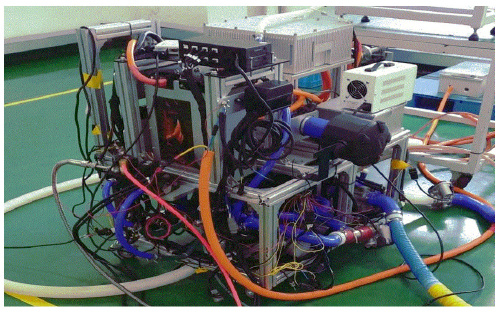
Table 2. The rate of change of the ohmic resistance.